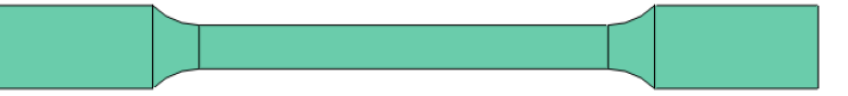
Figure 10. Model of sample created in Abaqus CAE.